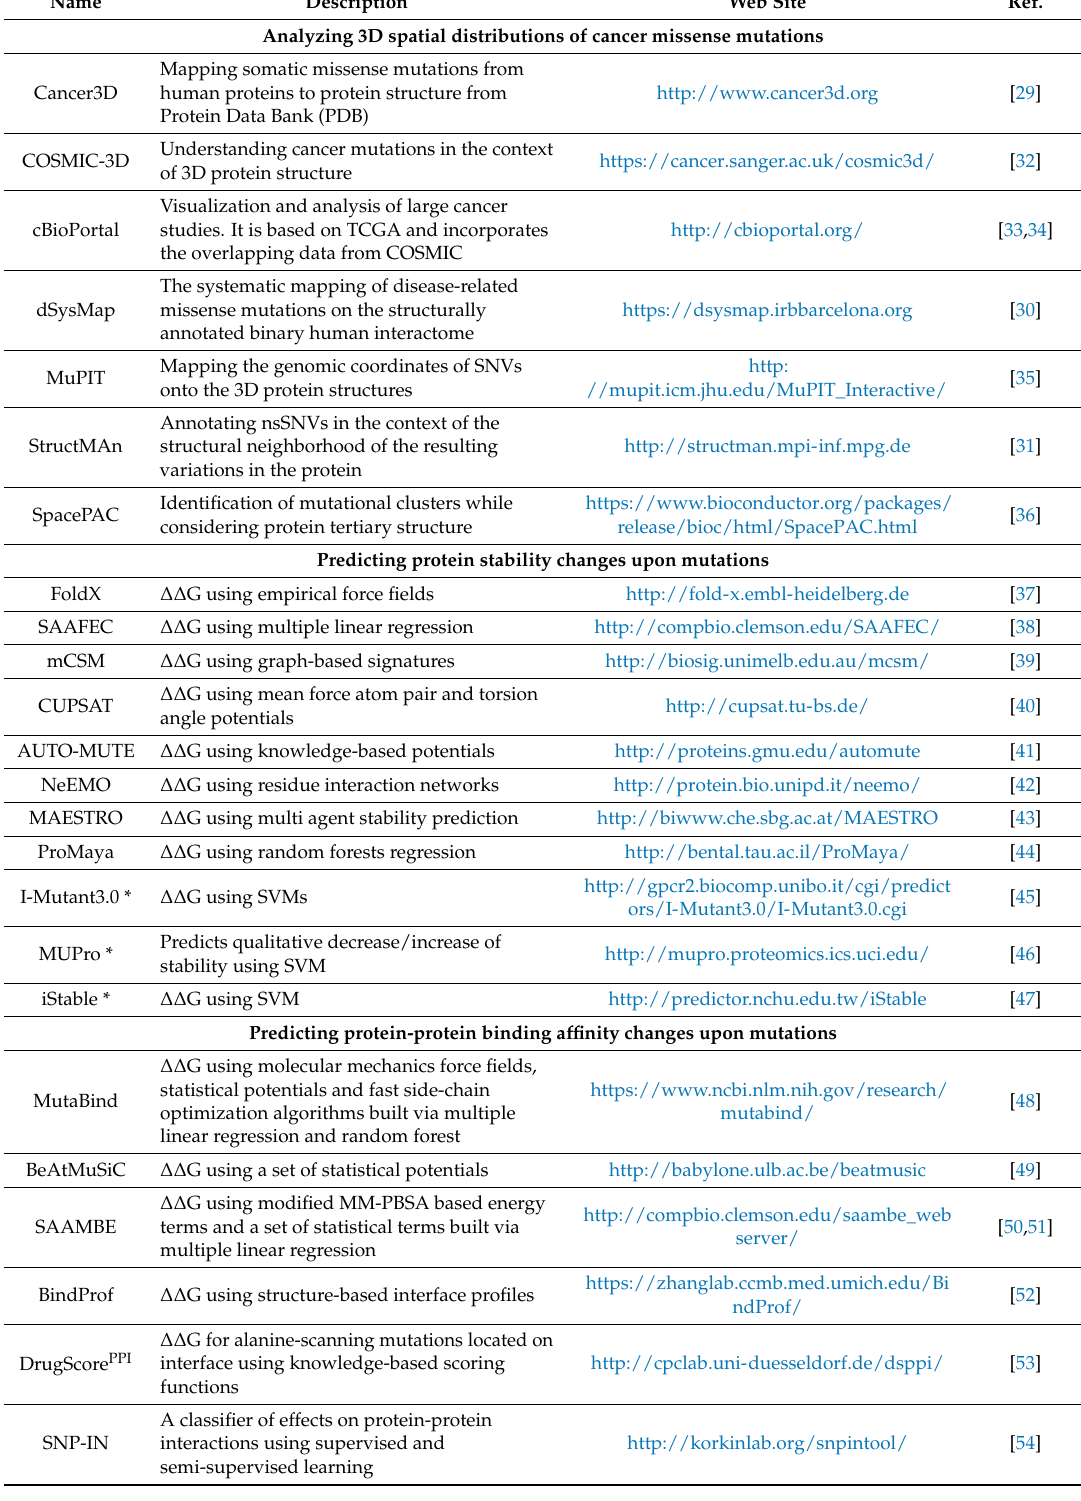
Table 2. A summary of online and free software resources for analyzing 3D spatial distribution of cancer missense mutations, predicting the effects of mutations on protein stability, protein-protein and protein-nucleic acid binding affinity. All resources need structure as an input except those with